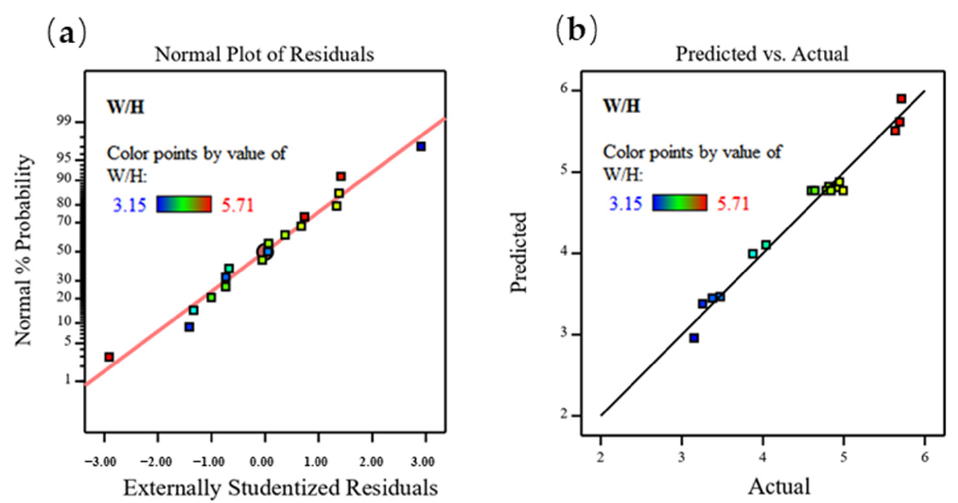
Figure 9. ( a ) Residual distribution of the W/H. ( b ) Relationship between the predicted and actual values of the W/H.